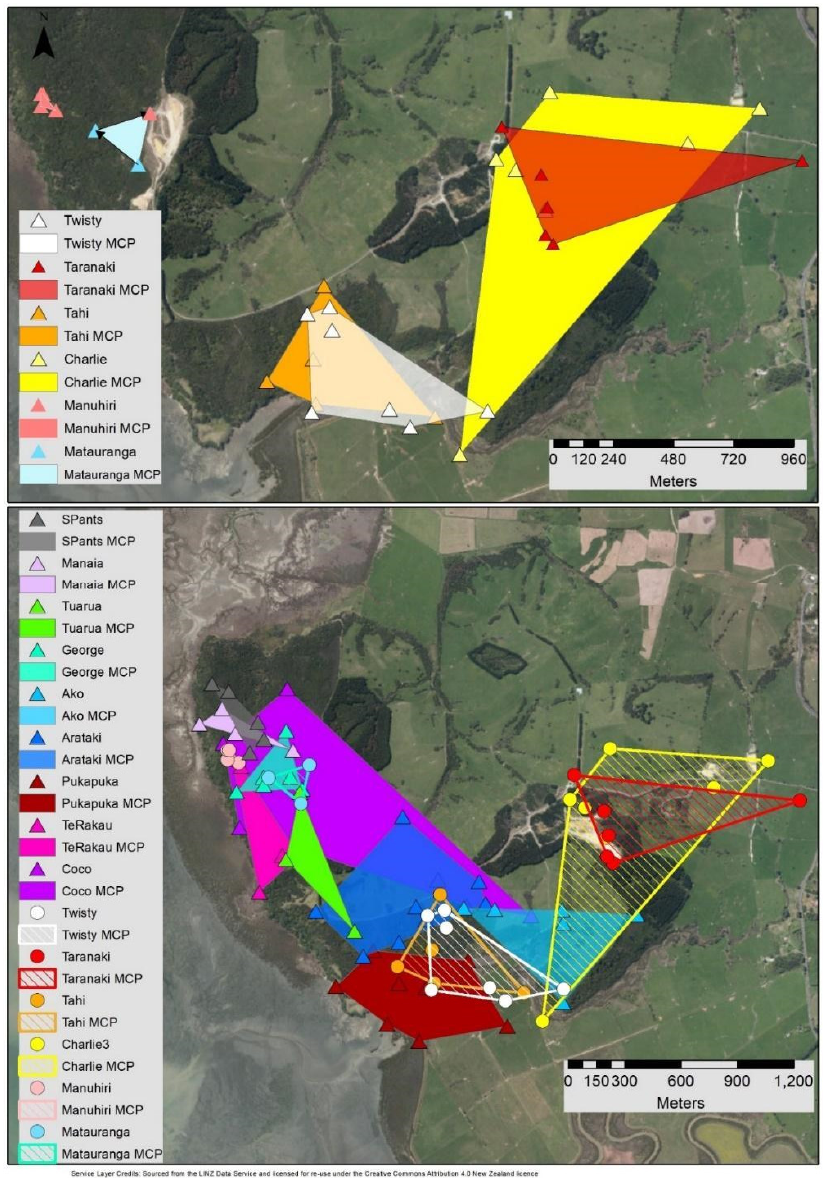
Figure 2. Roost areas for each bird determined using the Minimal Convex Polygon in hectares (MCP ha) for kiwi translocated in 2013 (upper figure) and 2014 (lower figure with 2013 birds in hatched polygons).